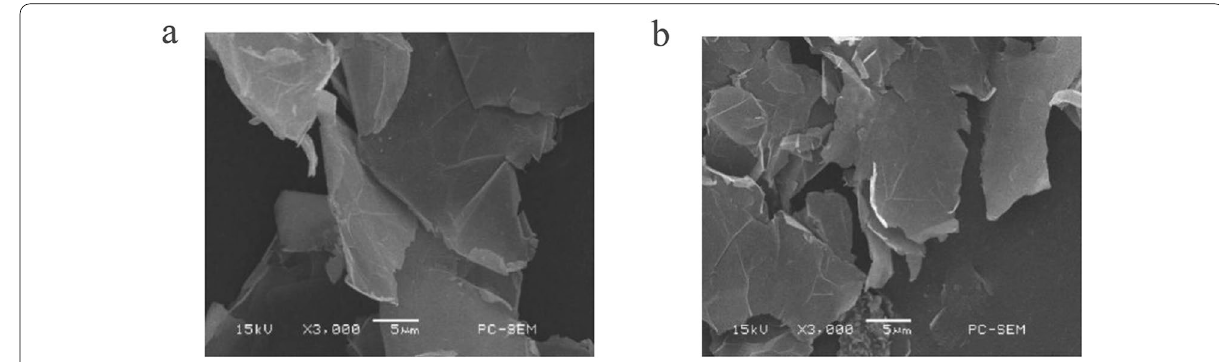
Fig. 1 SEM image of GP ( a ) and Sn‑GP ( b )